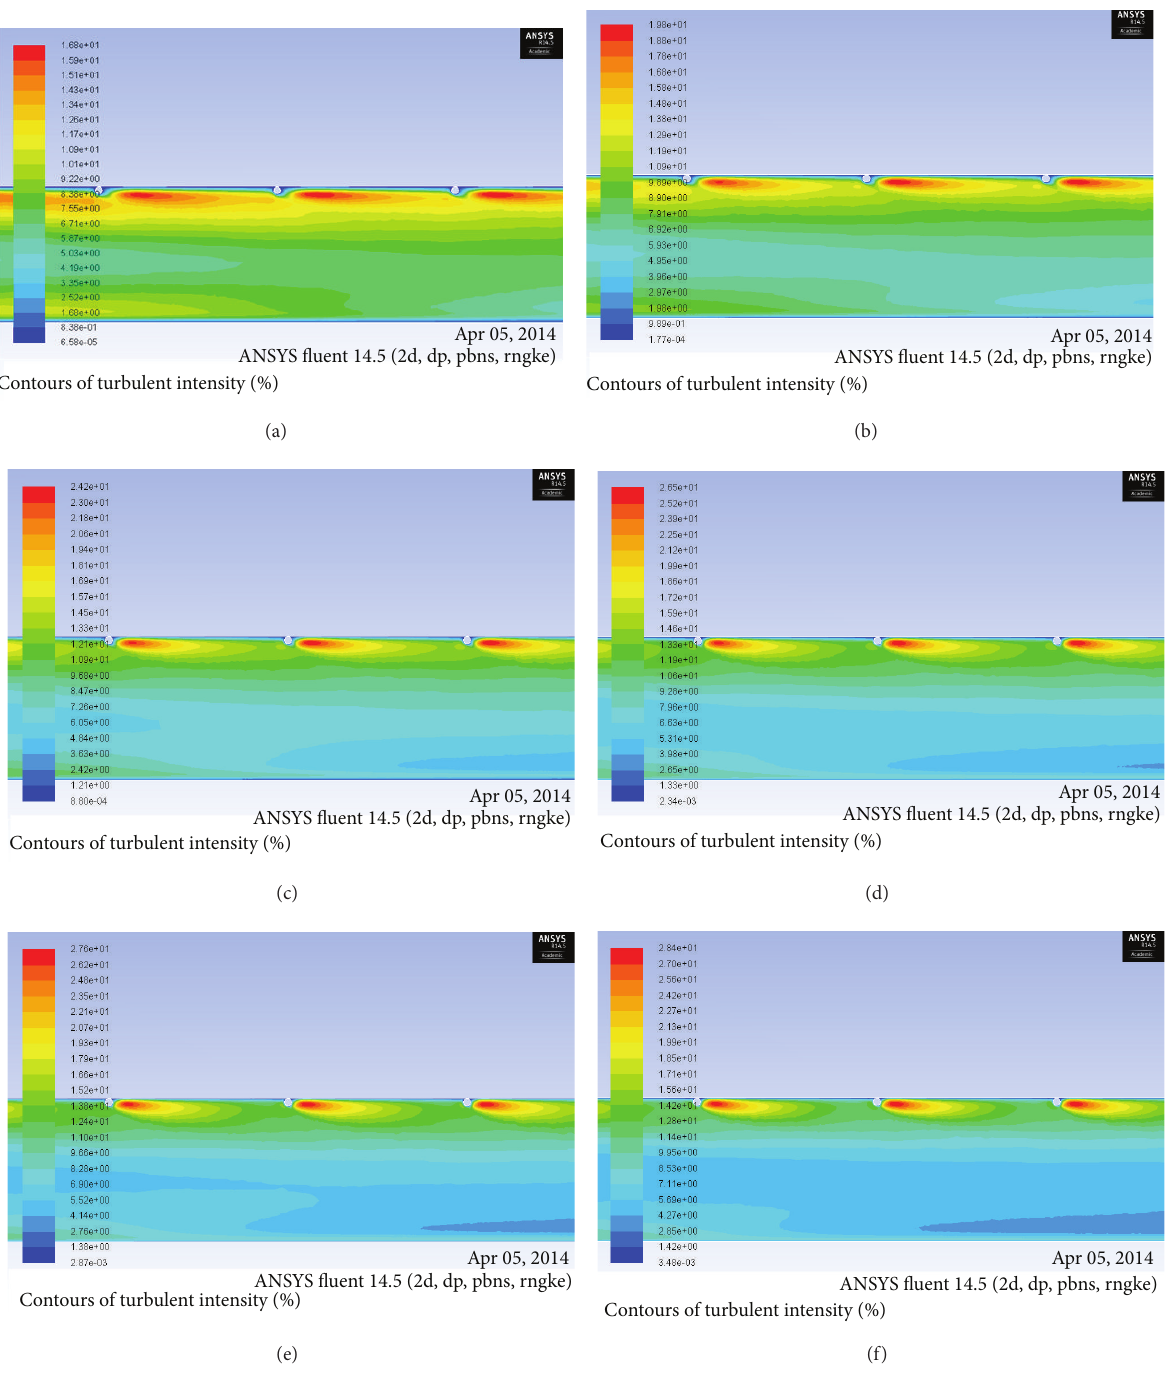
Figure 9: Contour plot of turbulence intensity for 𝑃/𝑒 = 25, 𝑒/𝐷 = 0.03 for Reynolds number of (a) Re = 3800, (b) Re = 5000, (c) Re = 8000, (d) Re = 12000, (e) Re =15000, and (f) Re = 18000.